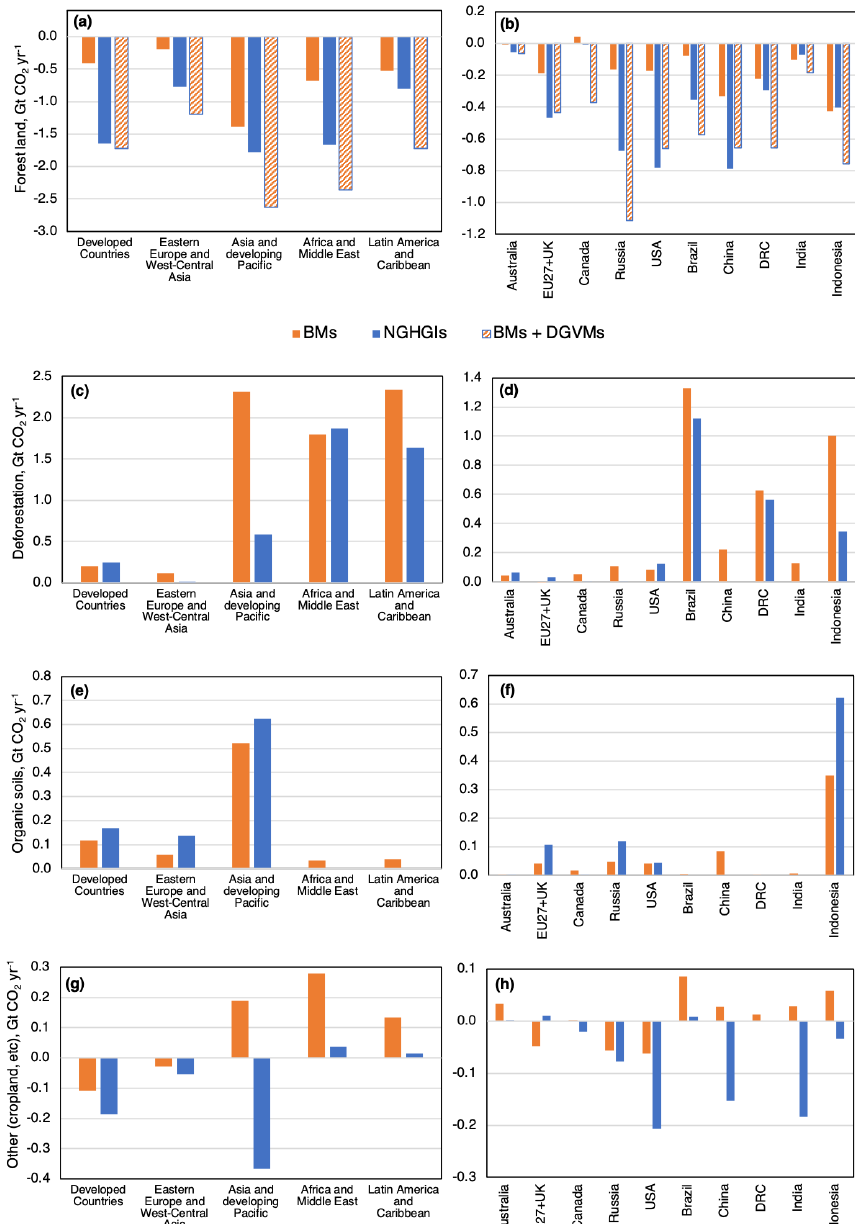
Figure 9. Land CO 2 fluxes (average 2000–2020) from BMs, from the sum of BMs and DGVMs (in non-intact forest only) and from NGHGIs for forest land (panels a and b , including harvested wood products and excluding organic soils), deforestation ( c and d ), organic soils ( e and f ) and other ( g and h , including cropland, grassland, etc). A larger number of country-level data are included in Table S1. Results for all countries are included in the online repository (Grassi et al.,